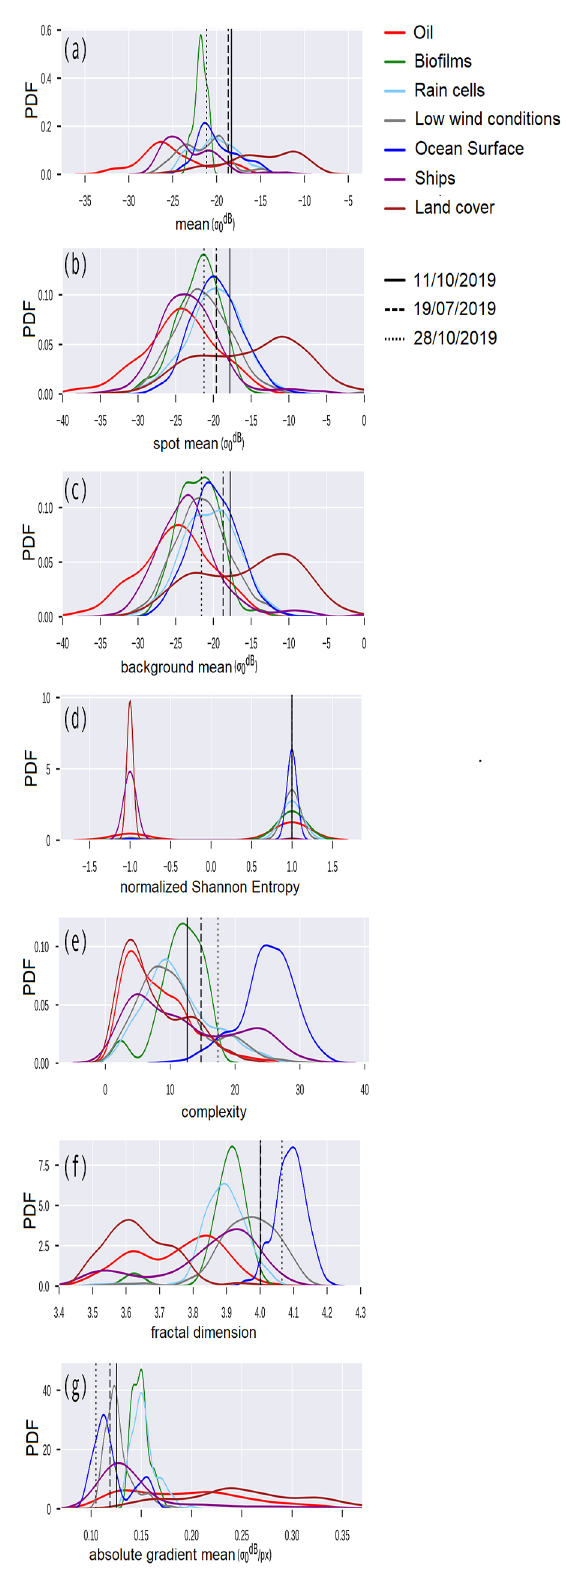
Figure 4. Feature probability density functions based on the seven target classes. The three black vertical lines show the average attribute values for the Sentinel-1A SAR images used as case studies: 11/10/2019 (continuous line), 19/07/2019 (dashed line), and 28/10/2019 (dotted line). The top first three panels (a, b, and c) showed a tendency to separate oil-related surface signature peaks. In contrast, the normalized Shannon entropy (d) showed that ship and land cover could be easily